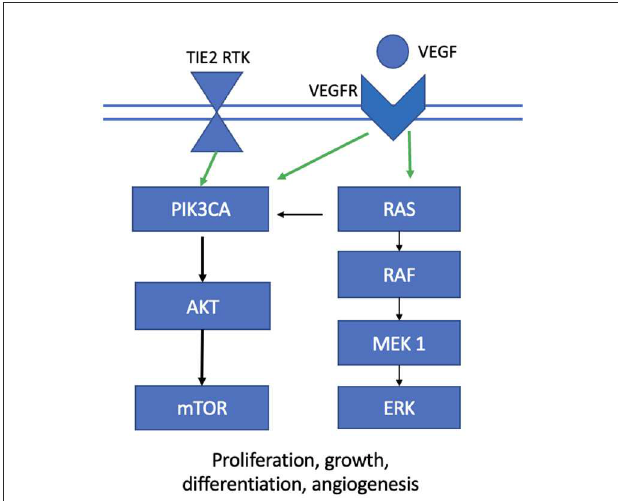
FIGURE1 Two major cellular signaling pathways implicated in the development of vascular malformations. TIE2 RTK, TEK gene receptor tyrosine kinase; VEGF, vascular endothelial growth factor; VEGFR, vascular endothelial growth factor